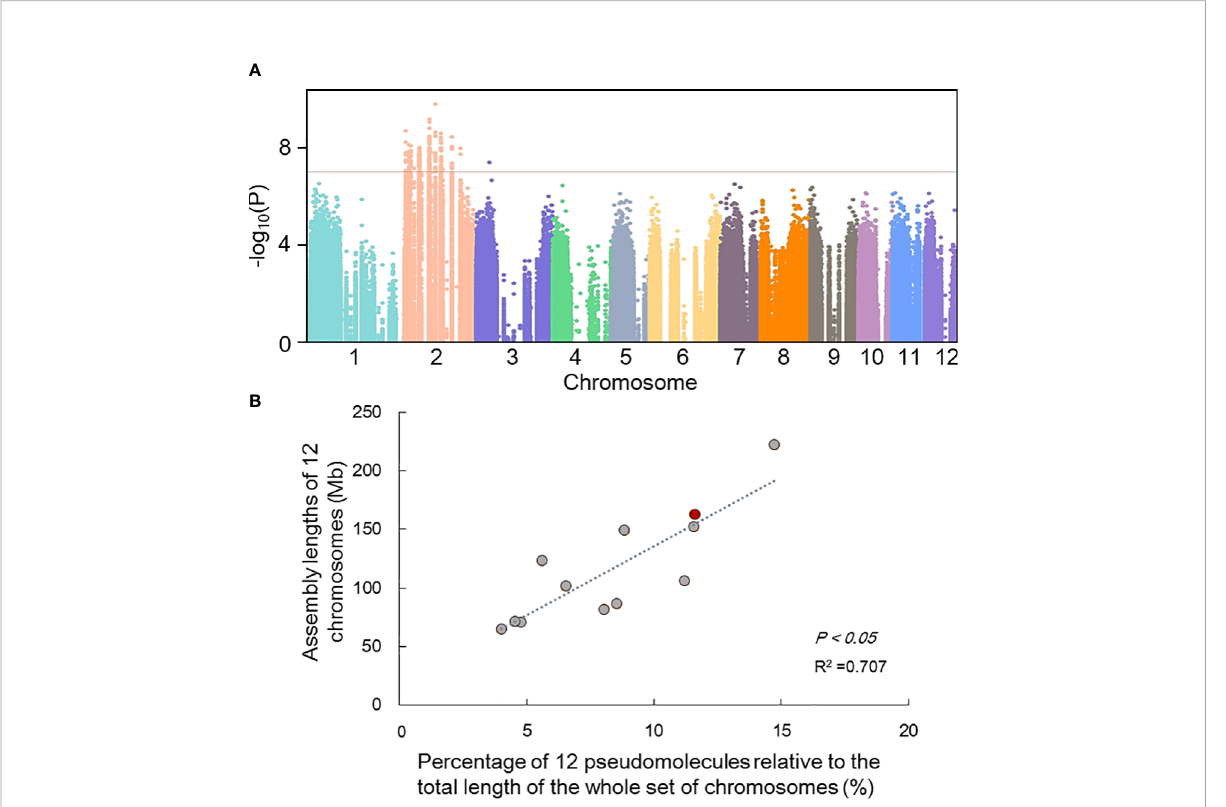
FIGURE 4 Preliminary inference of sex-linked regions. (A) Manhattan depicting signi fi cant SNPs identi fi ed using MLM model that showed association with gender. The red dotted line represents truncation criterion was set to - log10 P -value=7; (B) The correlation between the assembly lengths and observed physical lengths of all chromosomes. The red dot represents chromosome 2 of H. tibetana